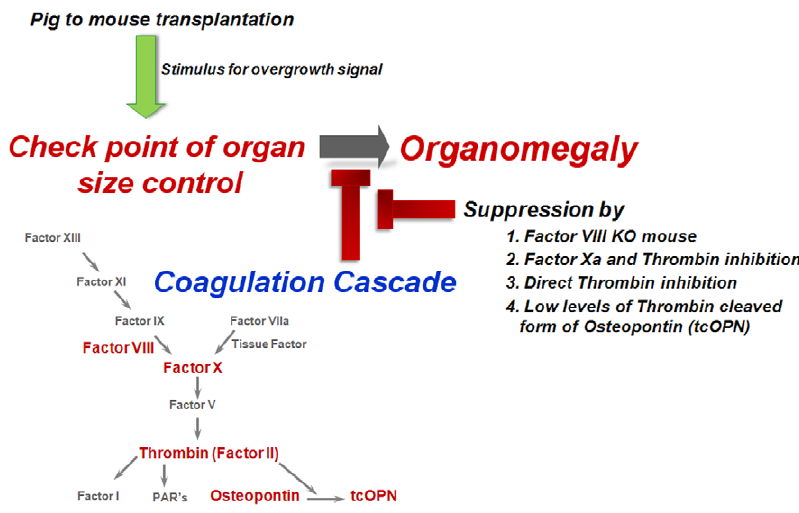
Figure 7. Overgrowth stimulus regulation by factors in the coagulation cascade.